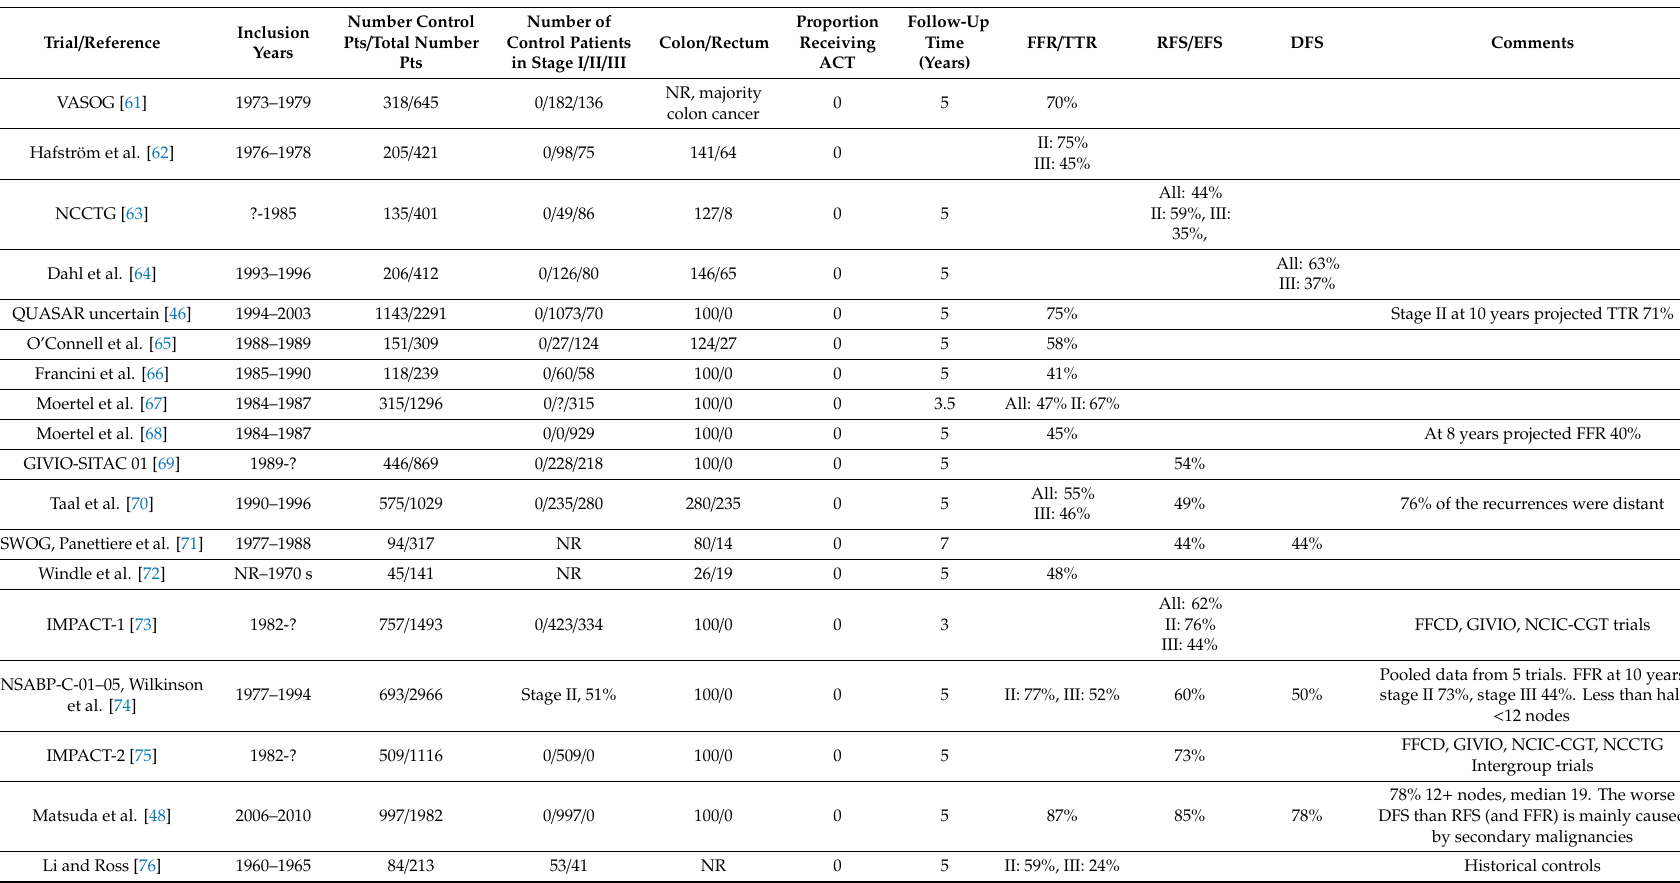
Table 1. Time to recurrence rate / freedom from recurrence and recurrence-free and disease-free survival in adjuvant predominantly colon cancer trials with a control group where systemic chemotherapy was given in the experimental